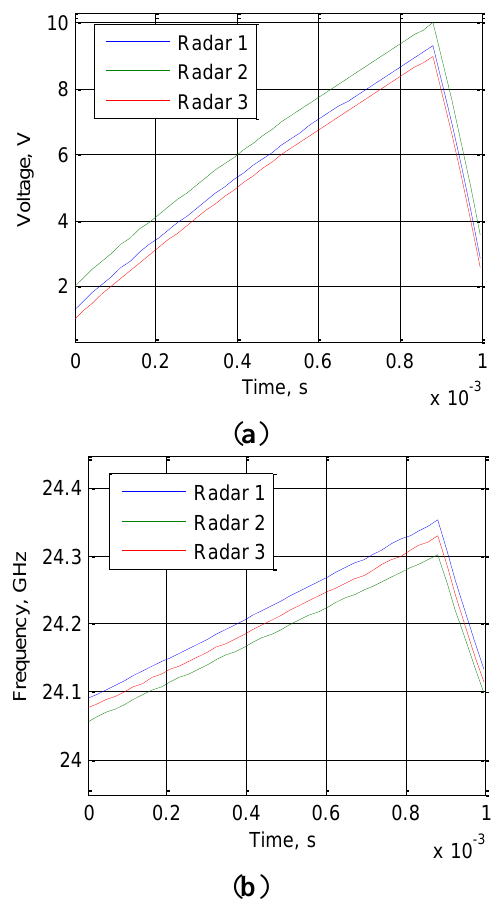
Figure 10. Configured OLFM-CW waveforms ( a ) Voltage ramps ( b ) Frequency